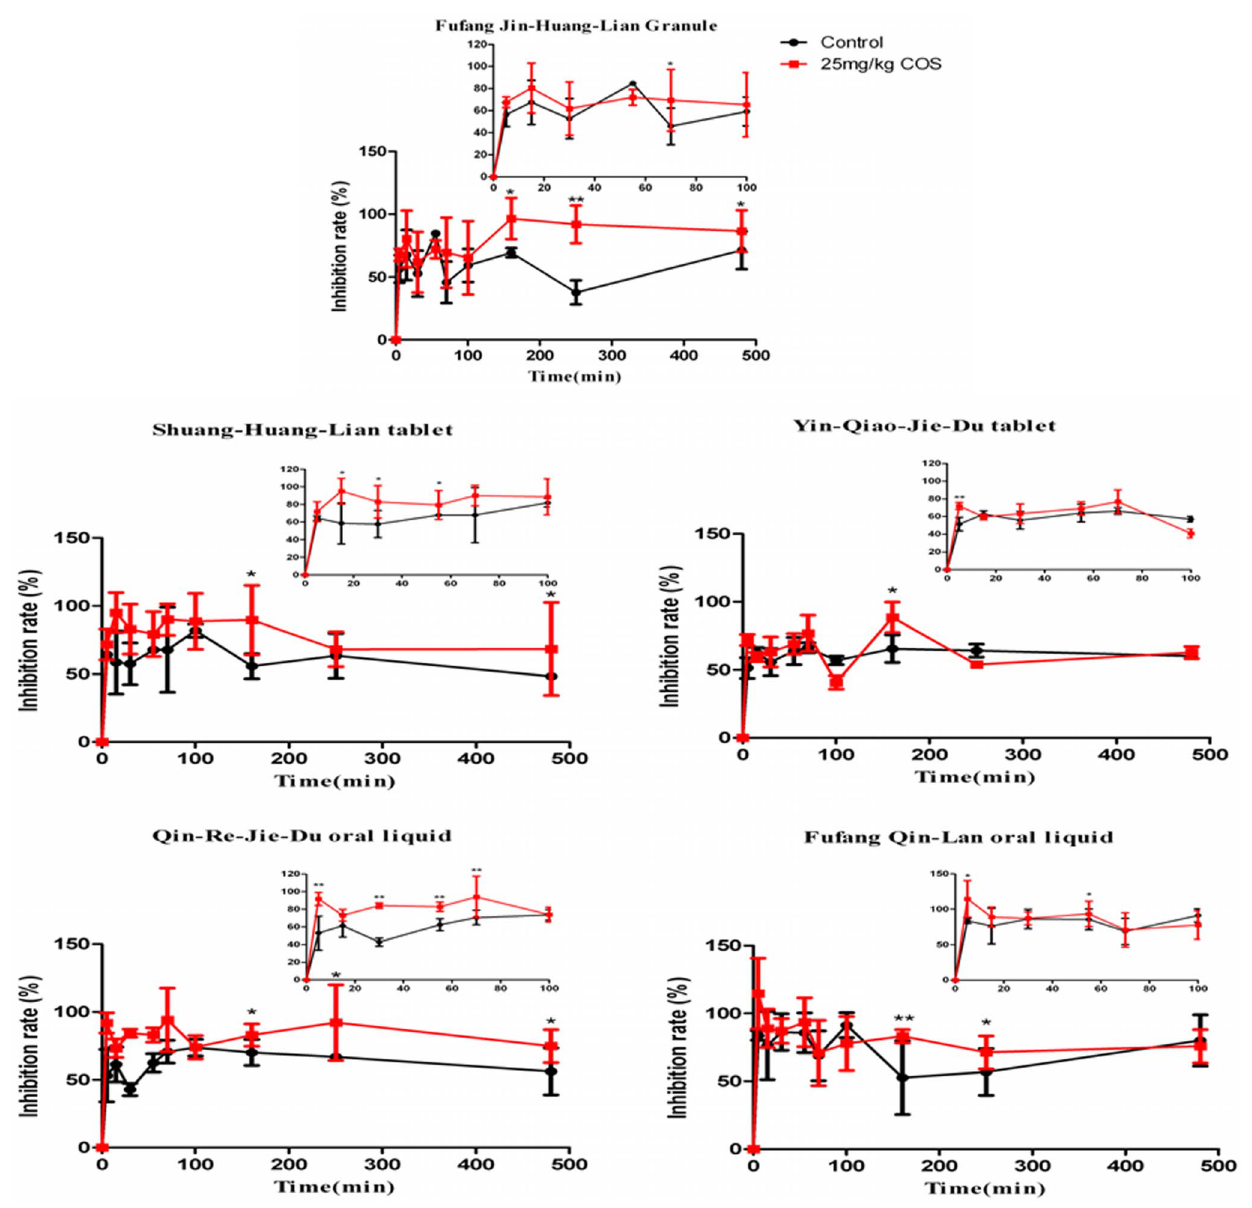
Figure 10. Effect of FlosLonicerae-FructusForsythiae herb couple preparations with or without COS at the dosage of 25 mg/kg on influenza virus. Inhibition rate was assayed with MTT 48 hours later and expressed as percentage of controls (data 6 S.D. n =8). ( * ) P , 0.05 and ( ** ) P , 0.01.